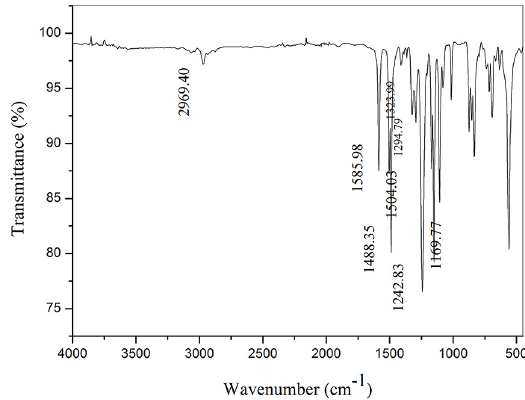
Figure 5: The FTIR-ATR spectra of the control